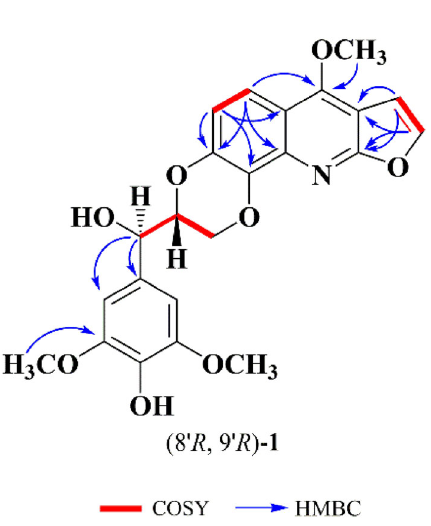
Fig. 2 Key 2D NMR correlations of ( ± )-zanthonitidine A ( 1